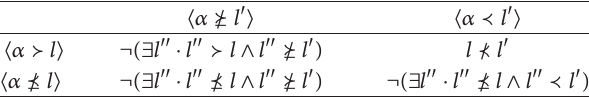
Table 2: Conjugated